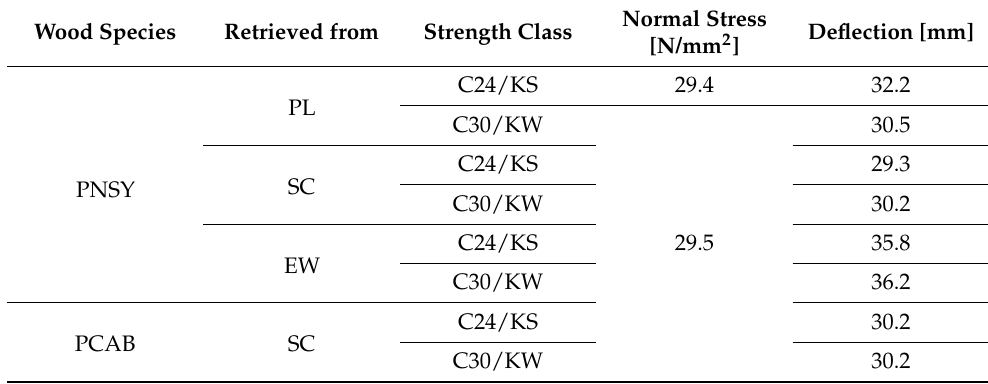
Table 6. Normal stresses and deflection (displacement) of the B version long frames made of glued material with a finger-jointed lamella length of 200